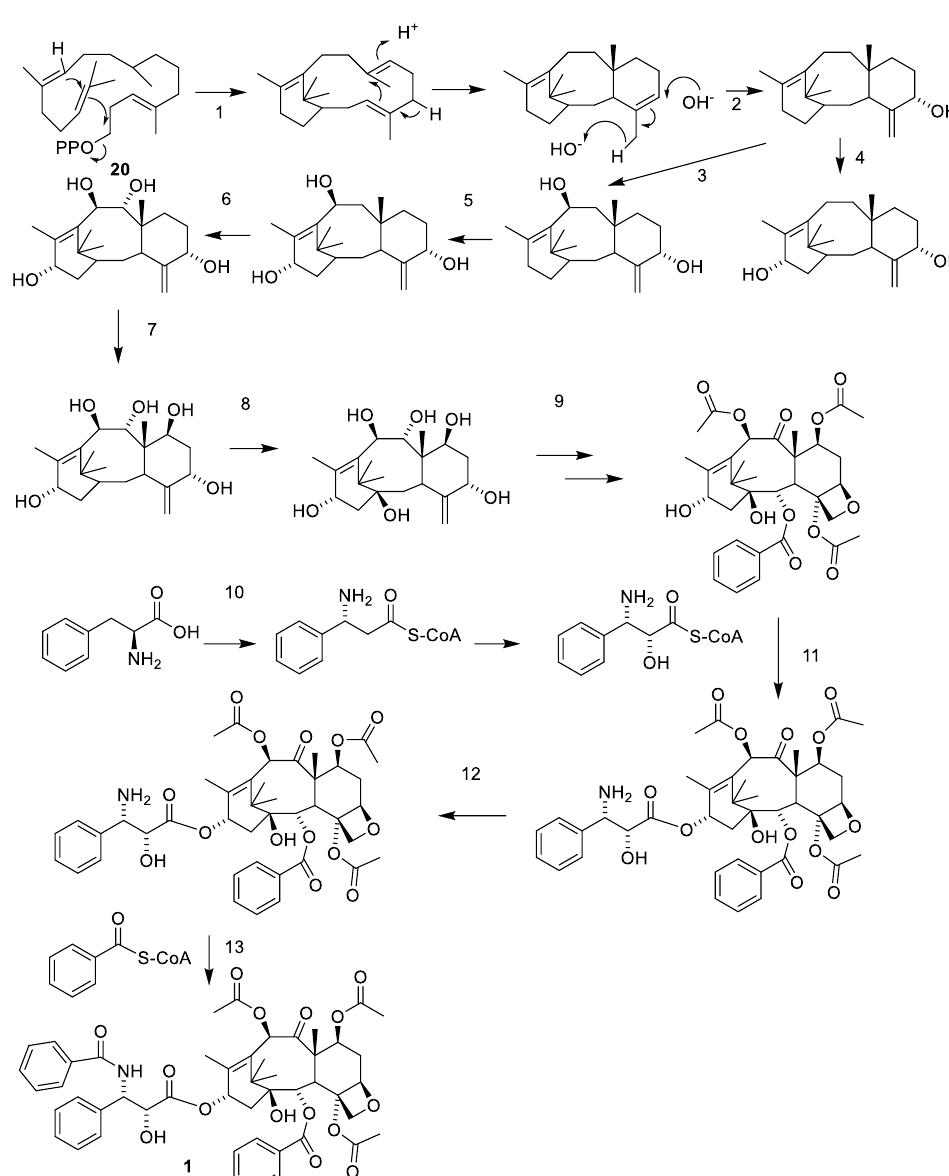
Figure 6. Biosynthesis of paclitaxel ( 1 ) starting form geranylgeranyl pyrophosphate ( 20 ). The sequence of oxidation begins with C-5 then C-10, C-13, C-9, C-7 and finally C-2. The oxetane group is introduced by epoxidation of the C-4-C-20 double bond. The oxidation of C-9 occurs at the same time as the formation of the oxetane group. The O-13 side chain is introduced as isophenylalanine, which after esterification is oxygenated at C-2 and N -benzoylated. Enzymes: taxadiene